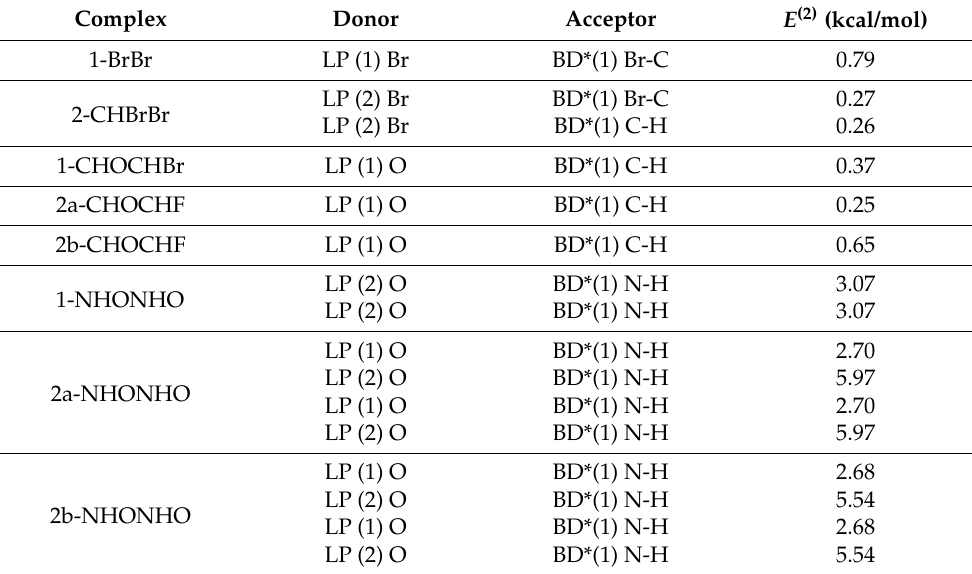
Table 4. NBO donors and acceptors and their second-order perturbation energy E (2) for dimers of 1 and 2 . LP, BD* stand for lone pair and anti-bonding orbital, respectively. The results were obtained with the MP2/def2-TZVP theory